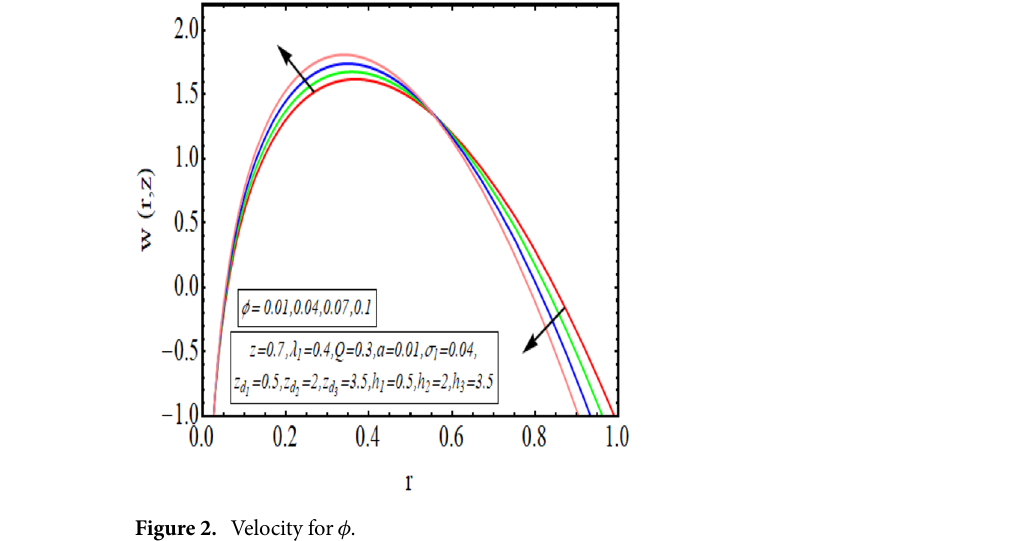
Figure 2. Velocity for φ